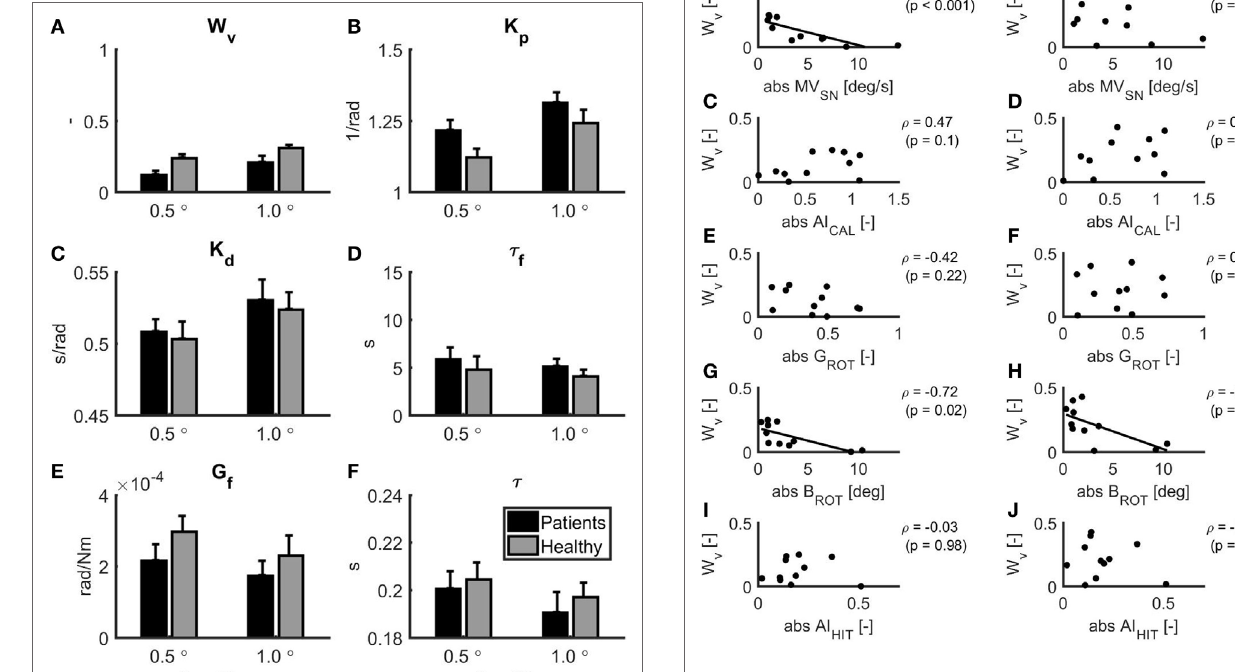
FigUre 4 | Scatterplots of the relations between the absolute values of the mean eye velocity during spontaneous nystagmus examination (a,B) , the asymmetry index as established with the caloric test (c,D) , the ocular response gain during the rotational chair test (e,F) , the ocular response bias during the rotational chair test (g,h) and the asymmetry index as established with the head impulse test (i,J) and the vestibular weight during a peak-to- peak disturbance amplitude of 0.5° (a,c,e,g,i) and 1.0° (B,D,F,h,J) . In case of a significant relation, the linear fit is included in the